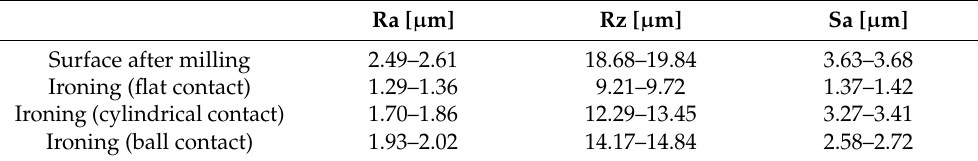
Figure 24. Scanning electron microscopy of the results: ( a ) finished UHMWPE surface ‐ free of burrs, smooth (v c = 5 m/min, a p = 0.01 mm, a e = 0.2 mm), ( b ) surface roughness characteristics, ( c ) a piece of a very fine chip.